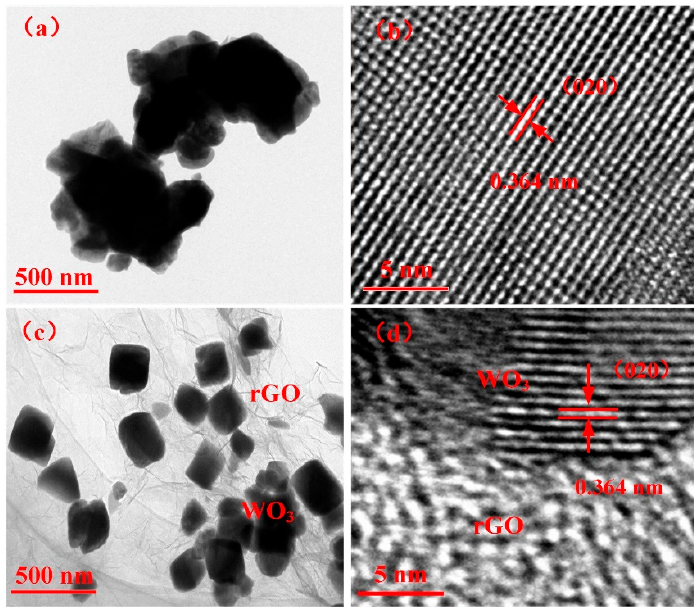
Figure 4. ( a ) Transmission electron microscopy (TEM) image of pure WO 3 nanolamellae; ( b ) high-resolution TEM (HRTEM) image of WO 3 nanolamellae; ( c ) TEM image of WG1 nanocomposites; and, ( d ) HRTEM image of WG1 nanocomposites.